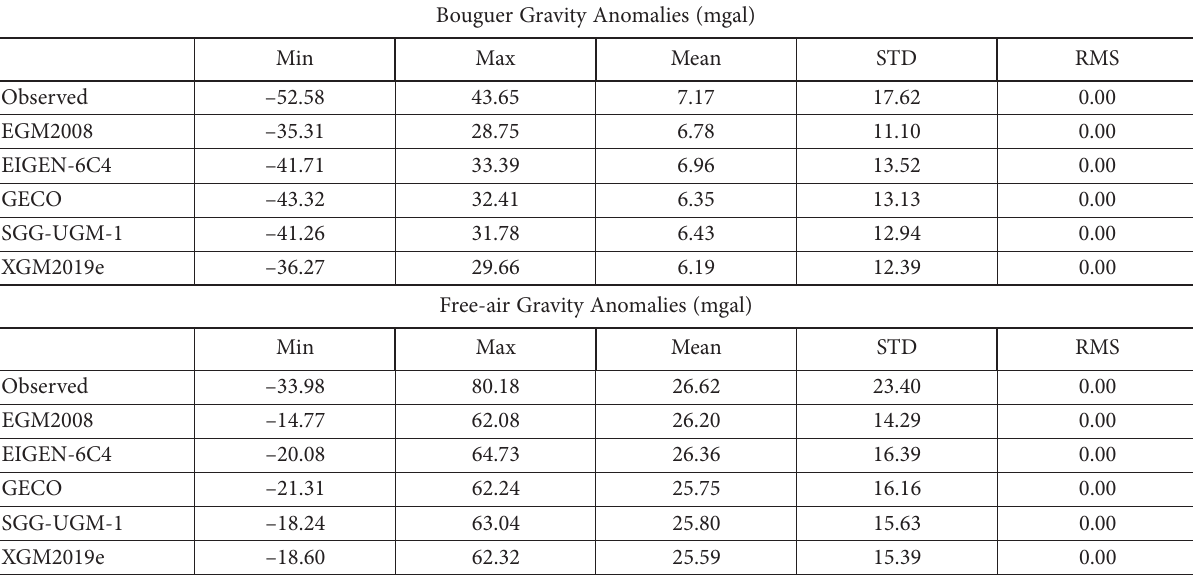
Table 4. Statistics of the ground-based and tailored GGM-derived Bouguer and free-air gravity anomalies